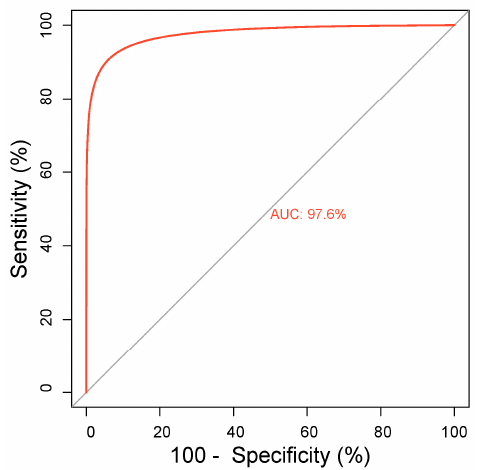
Figure 25. ROC Curve of SE-VGGNet Model.